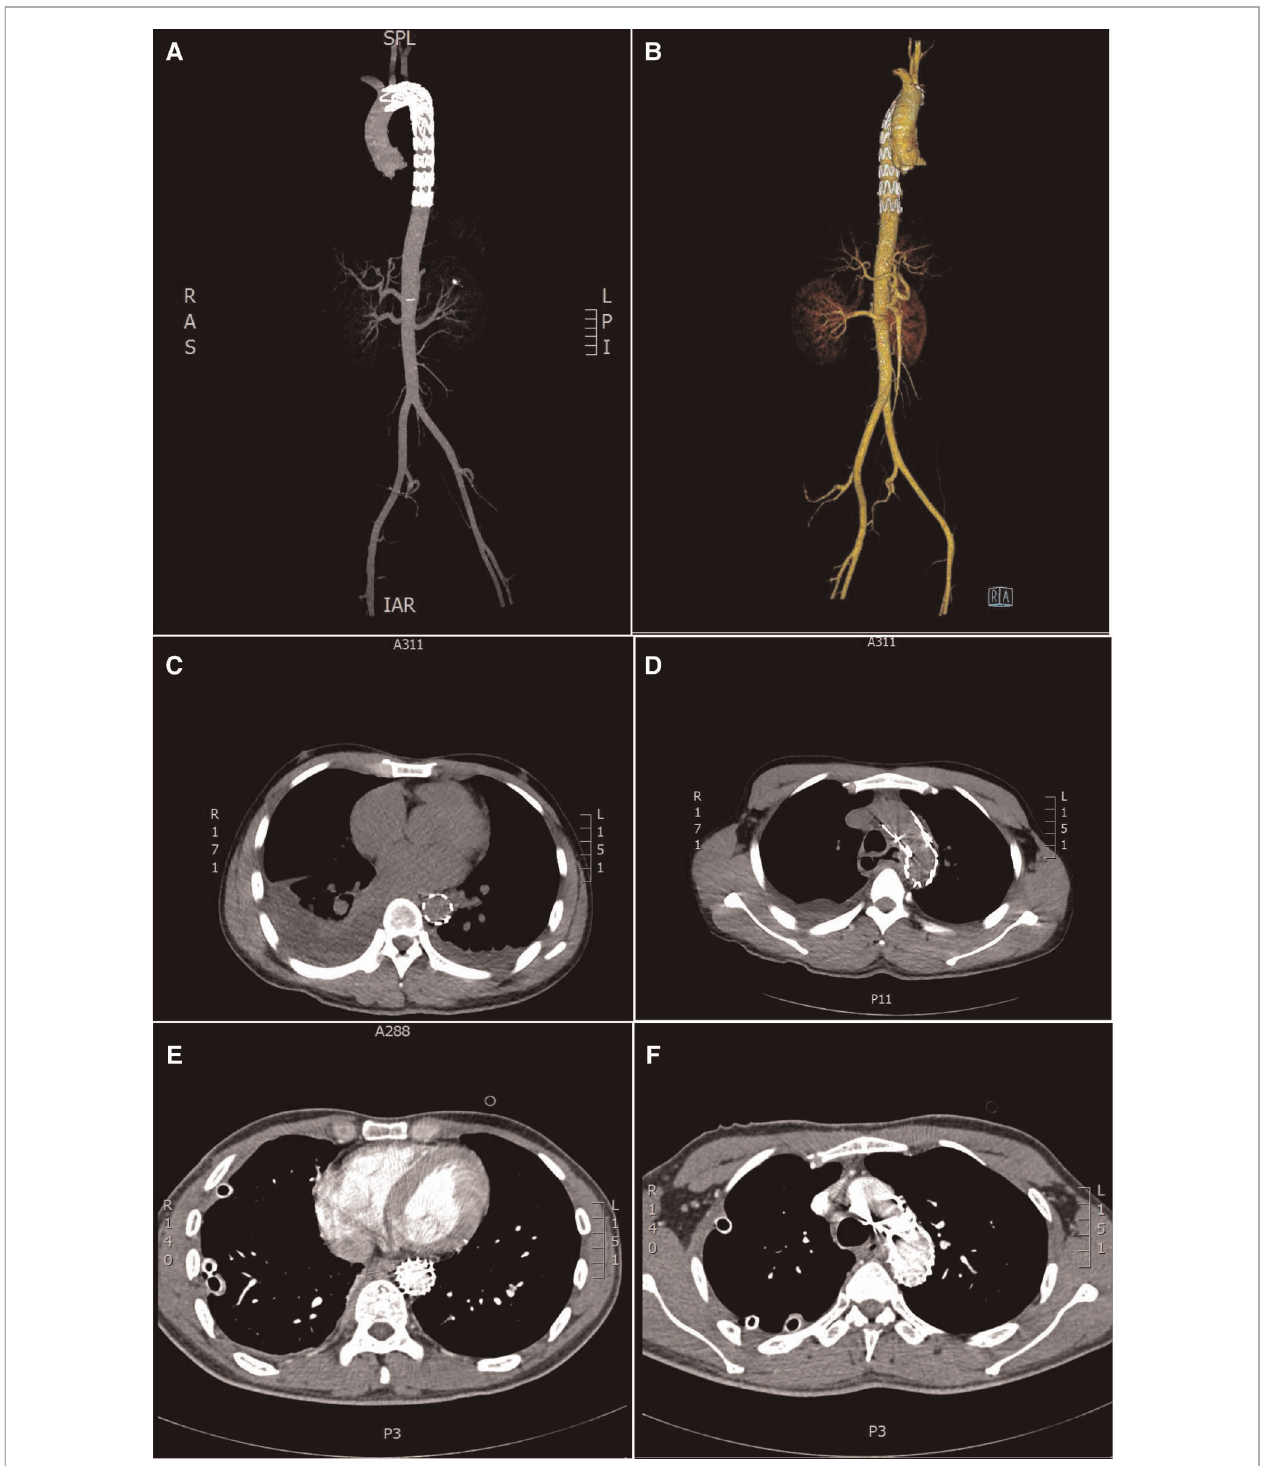
FIGURE 2 | Postoperative images. ( A and B ) different views of three-dimensional computed tomography angiography (CTA): complete sealing of the break in the aortic wall after thoracic endovascular aortic repair (TEVAR). ( C , D ) Transverse view: complete sealing of the break in the aortic wall, no contrast agent extravasation was observed around the stent after TEVAR; bilateral pleural effusions were seen mainly on the right side. ( E , F ) Axial contrast-enhanced CT image after mediastinal debridement and drainage with cervical incision and video-assisted thoracoscopic surgery: the stent and drainage tube were observed clearly, with no fl uid on both sides of the